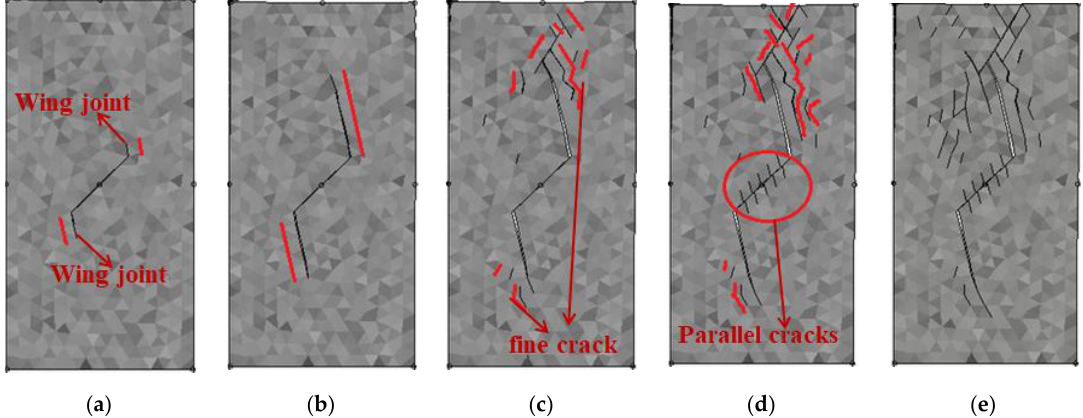
Figure 10. Failure process of Case 1 in uniaxial compression simulation experiment. ( a ) The ends of the preset joints cracked and wing cracks appeared; ( b ) Wing cracks expanded; ( c ) The width of the wing crack increased and fine cracks appeared; ( d ) A group of new oblique parallel cracks appeared; ( e ) The fine cracks became connected with the wing cracks and preset joints.